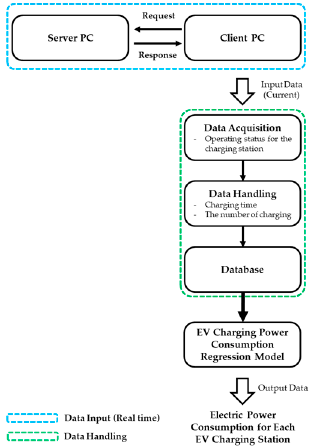
Figure 6. Overall structure of the database system. PC: personal